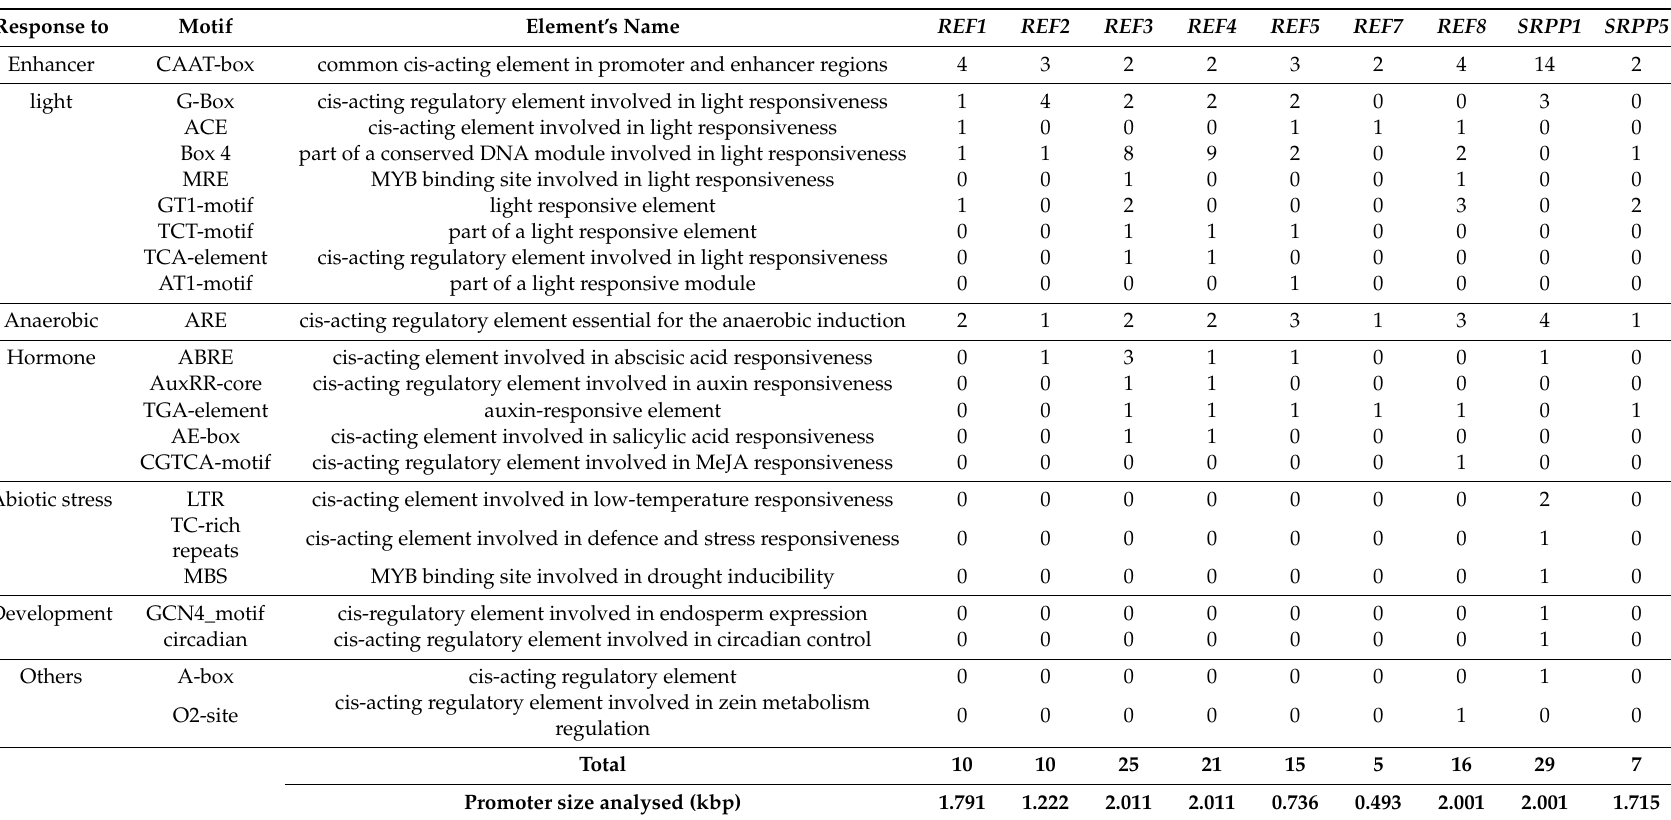
Table 3. Promoter sequence analysis of PB 260 sca ff old1222 with the PlantCare tool (http: // bioinformatics.psb.ugent.be / webtools / plantcare / html / ). All the cis -regulatory elements found are listed and